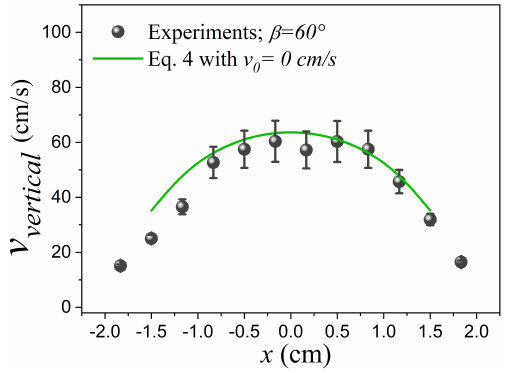
Figure 5. Velocity vs. x at the hopper outlet for lentil seeds, β = 60 ◦ and D = 4